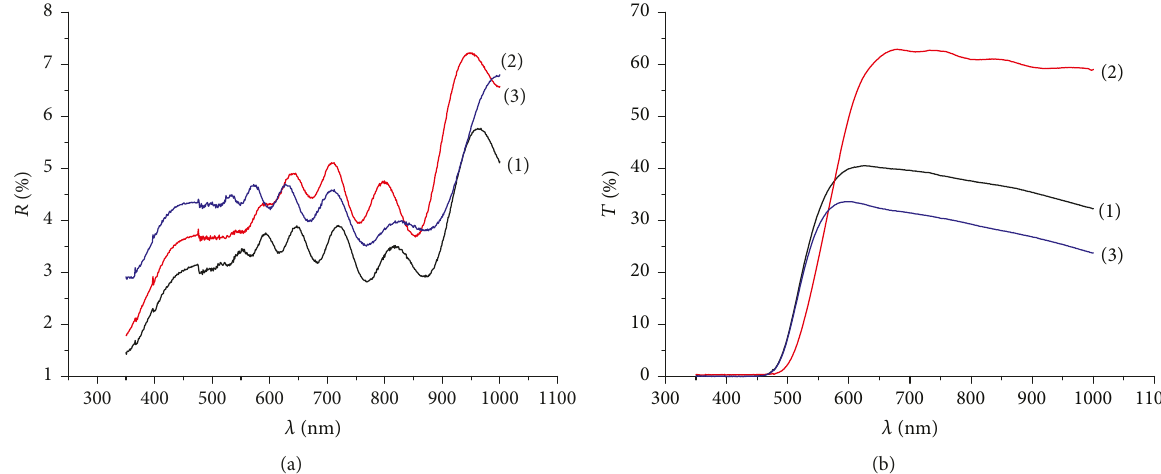
Figure 10: Reflectance (a) and transmittance (b) spectra of V 2 O 5 xerogel film: (1) initial film, (2) colored region, and (3) hydrogenated region.